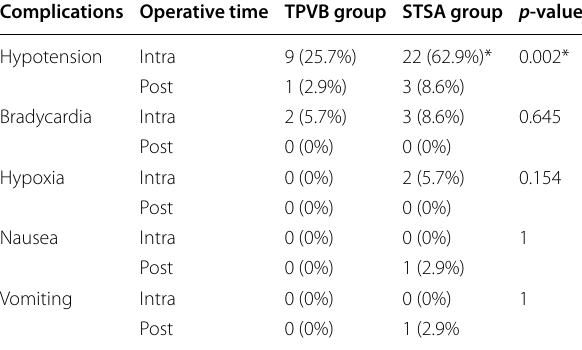
Table 8 The incidence of intra‑ and postoperative complications in number (percent)